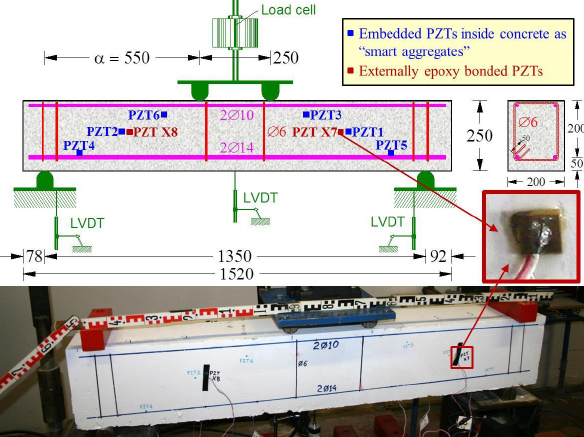
Figure 3. Geometrical and reinforcement characteristics the shear-critical RC beam and locations of the embedded (internal) and the bonded (external) PZT transducers